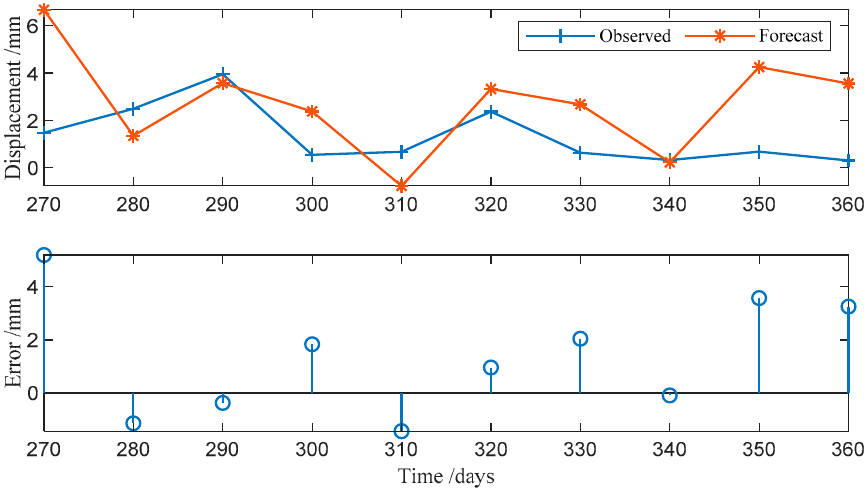
Figure 9. Forecast results and errors of landslide displacement.